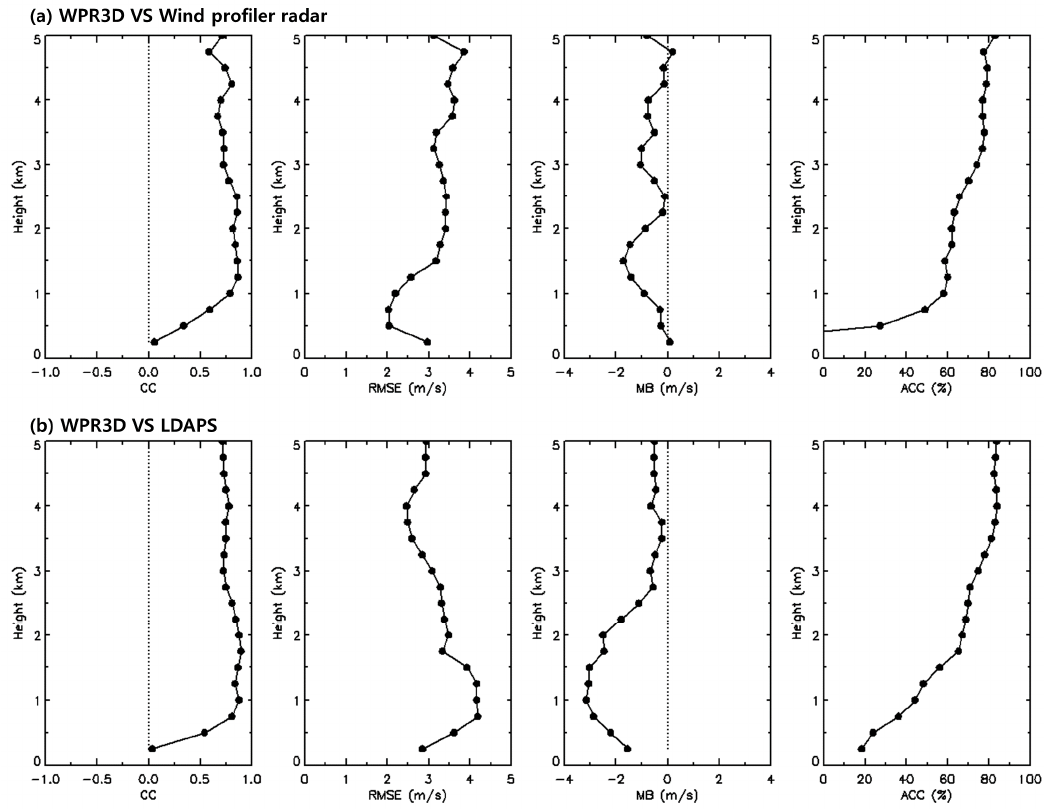
Figure 8. Skill scores with height used for validating the wind determined from WPR3D against the wind ( a ) from the single wind profiler at P0 and ( b ) from LDAPS.